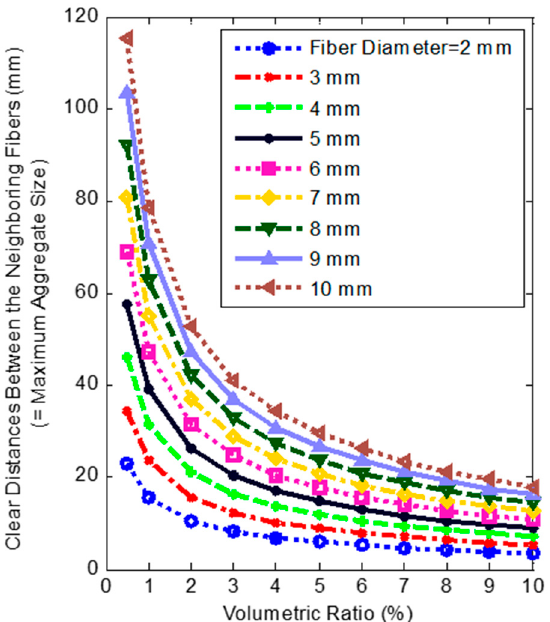
Figure 1. Effect of volumetric ratio and diameter on the required clear spacing between fibers [8].